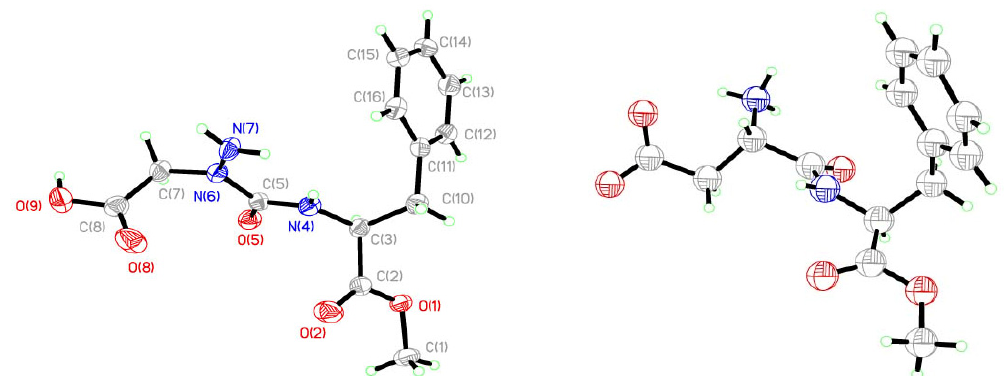
Figure 6. Aza-aspartame 9 and S,S- aspartame X-ray